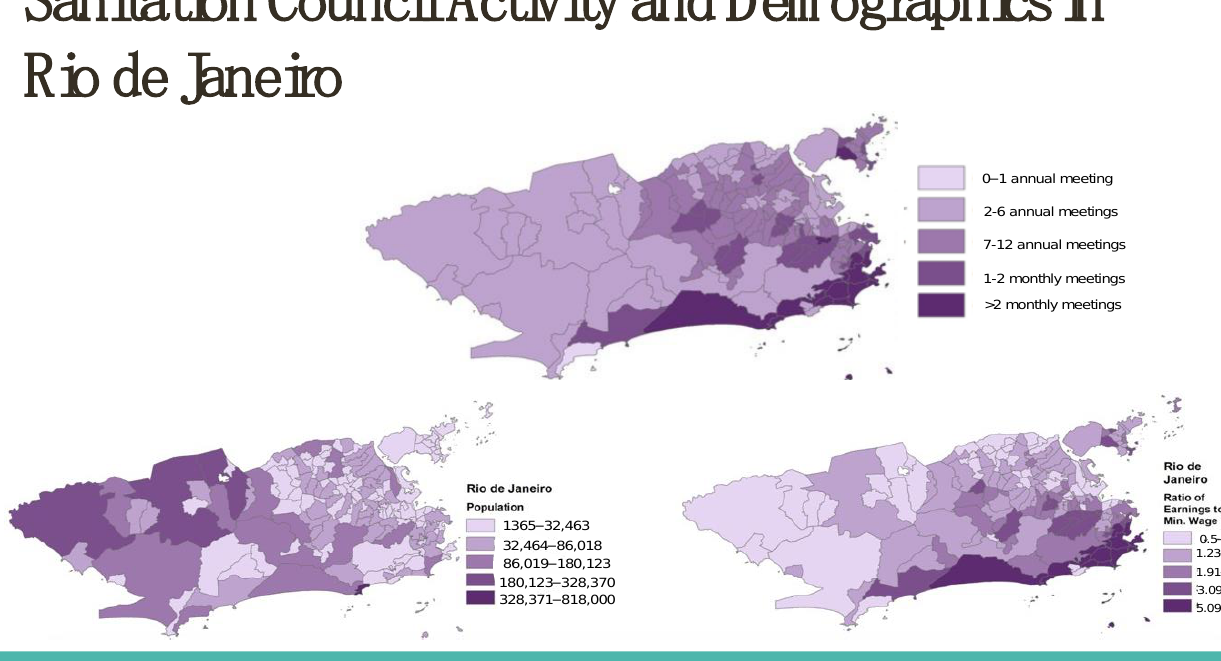
Figure 4. Sanitation Council Activity and Demographics in Rio de Janeiro.